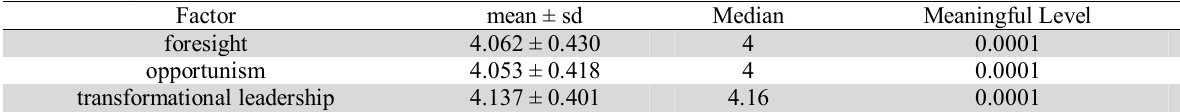
The Results of Single-Sample T Test; the Levels of Foresight, Opportunism and Transformational Leadership